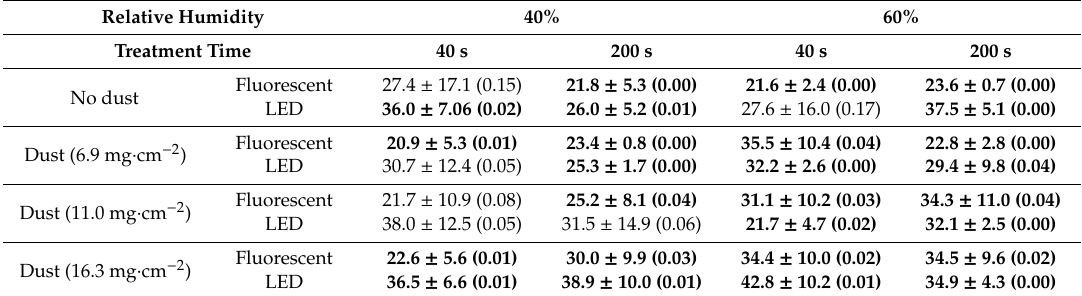
Table A16. O 3 mitigation under the di ff erent dust levels at a relative humidity of 40% and 60% in photocatalysis. Value in the table report % reduction ± standard deviation ( p -value) and are an average between treatments of NH 3 and H 2 S standard gases. Bold font signifies statistical